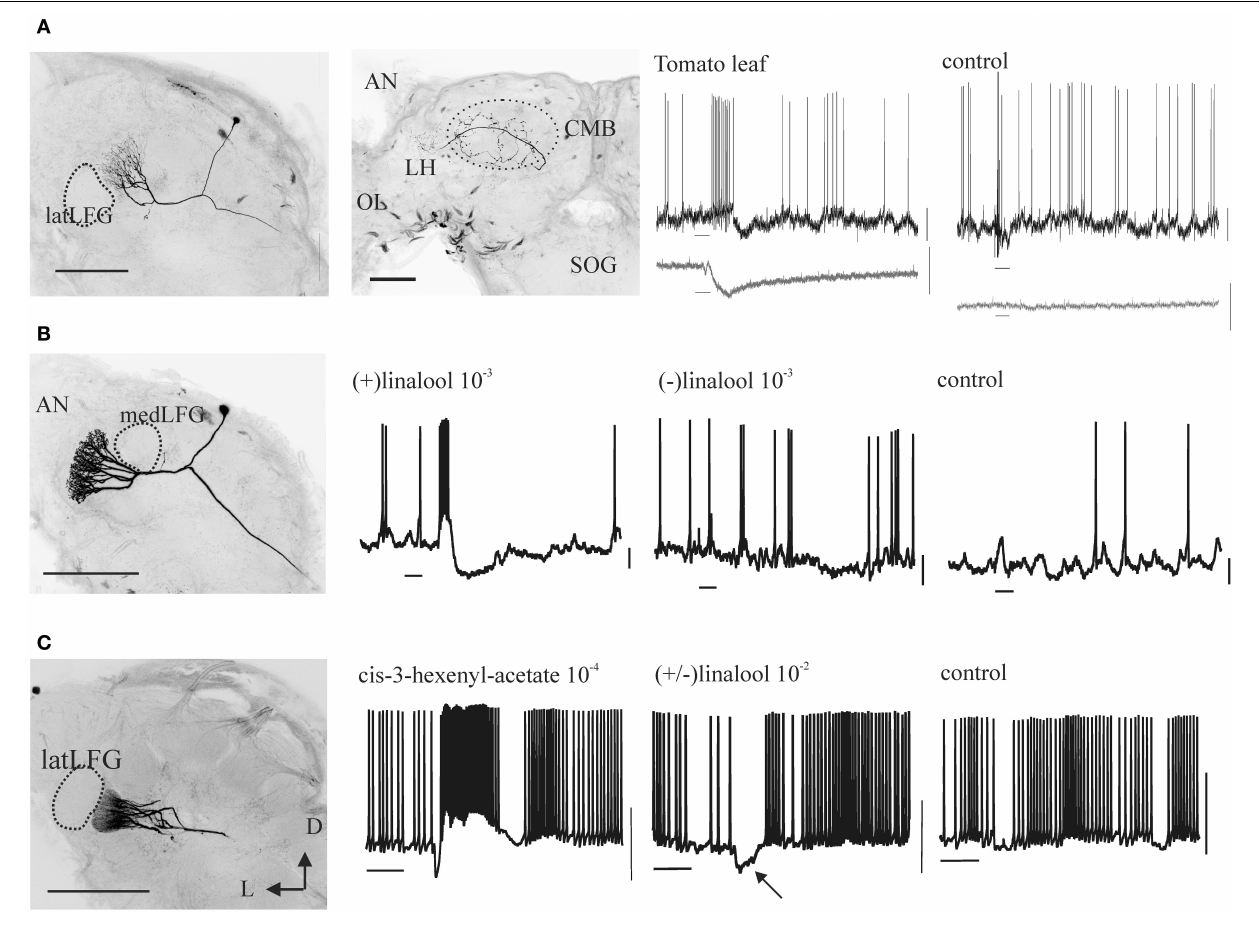
bars below records) with vegetative material (A) or odors (B,C) at the concentrations (% vol/vol) indicated. In (A) the bottom traces (in gray) show the simultaneously recorded electroantennograms (EAGs). Control stimuli are air from an empty cartridge (A) or the mineral-oil solvent (B,C) . Calibration bars: 10mV (intracellular trace), 1mV (EAG). Note that medLFG-PNs are excited by tomato leaf volatiles, latLFG-PNs respond differentially to the two linalool enantiomers, and G35-PNs are excited by cis -3-hexenyl acetate and hyperpolarized by ( ± )-linalool (arrow), i.e., by input to the adjacent